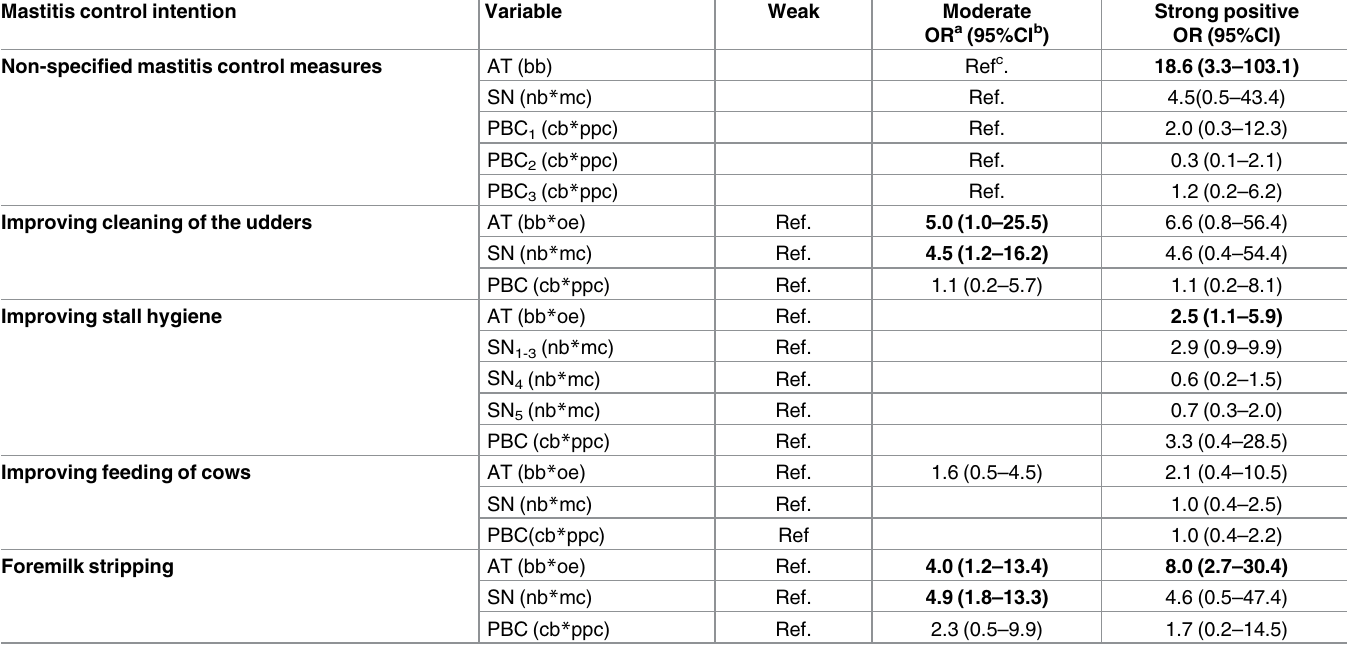
Table 5. Logistic regression model results describing the association of dairy farmers’attitude, subjective norms and perceivedbehavioral con- trol with intention towards implementing non-specified mastitis control measures,improving udder cleaning, improving stall hygiene, improving feeding of cows and implementing foremilk stripping, based on interviews with 134 farmersin North-Western Ethiopia. Significant odds ratios (P < 0.05)are given in